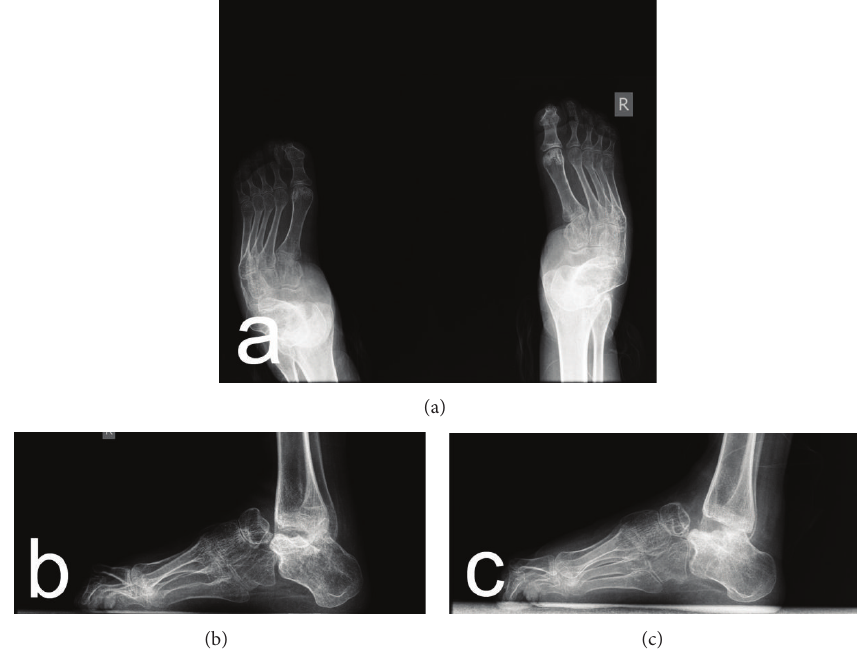
Figure 3: Postoperative anteroposterior (a) and lateral (b, c) radiographs of the patient (sister) with hereditary motor and sensory neuropathy type